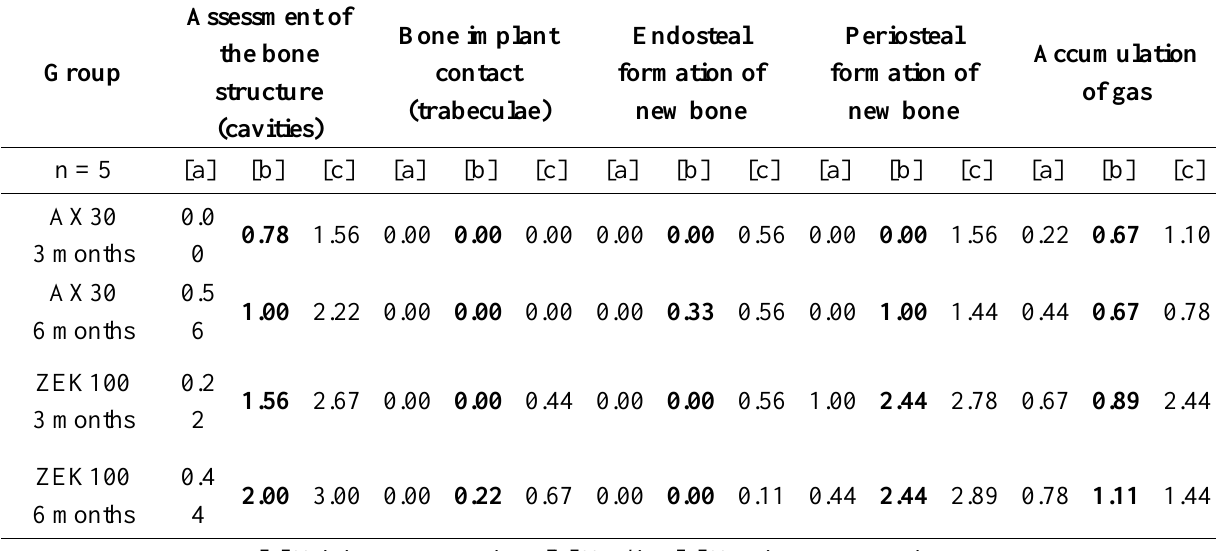
Table 2. Resulting score values of the 2D µCT images of the